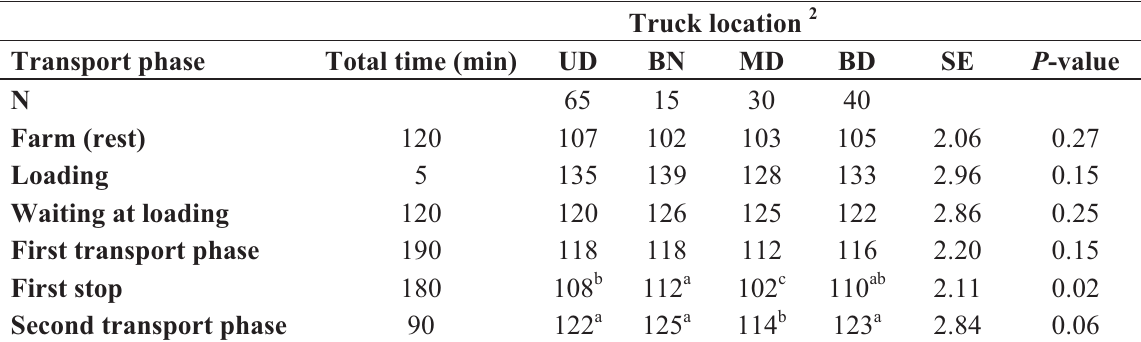
Table 2. Effects of animal location during transport in the PB trailer on heart rate average values 1 in